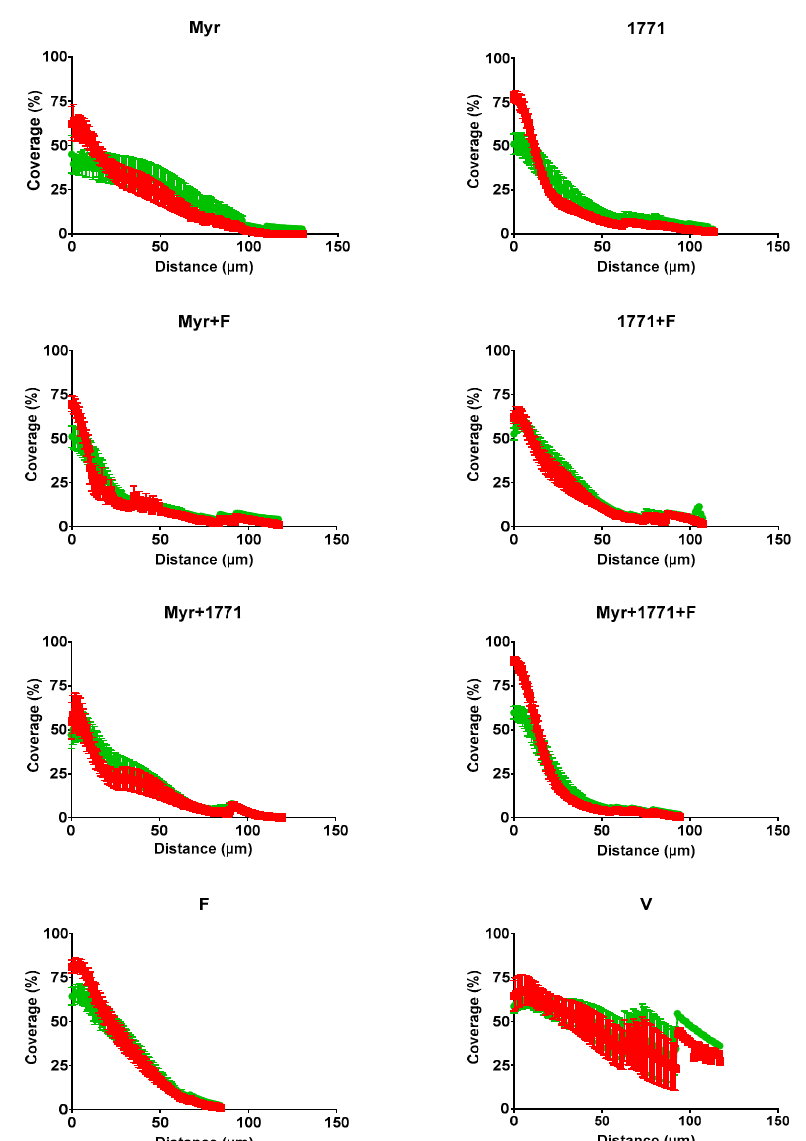
Figure 9. Profile of the distribution of bacteria (in green) and EPS (in red) in each of the topically treated biofilms. The data shown are the mean and standard error percentage coverage per area from the interface substratum / biofilm (hydroxyapatite disc) to the top (outer layer) of each biofilm at 67 h (n = 12 images per biofilm).